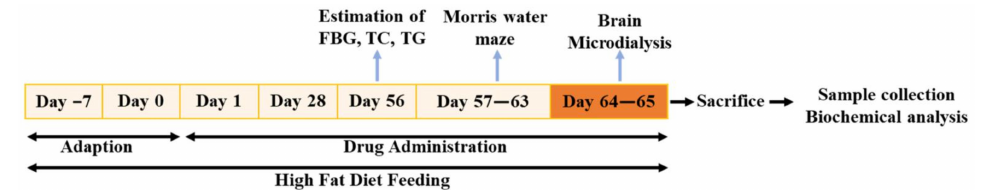
Figure 1. Schematic diagram of the experimental design. (Note: FBG: Fasting Blood Glucose, TC: Total Cholesterol; TG: Triglycerides).